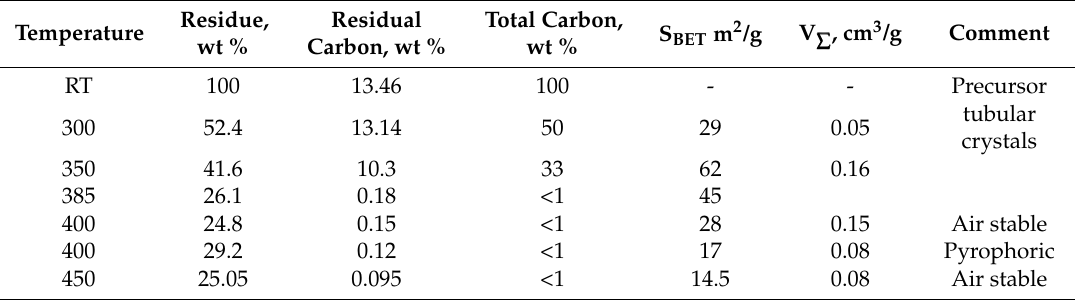
Table 1. Results of thermal treatment of [Co(NH 3 ) 6 ][Fe(C 2 O 4 ) 3 ] ∙ 3H 2 O in argon flow (heating rate 5°/min).